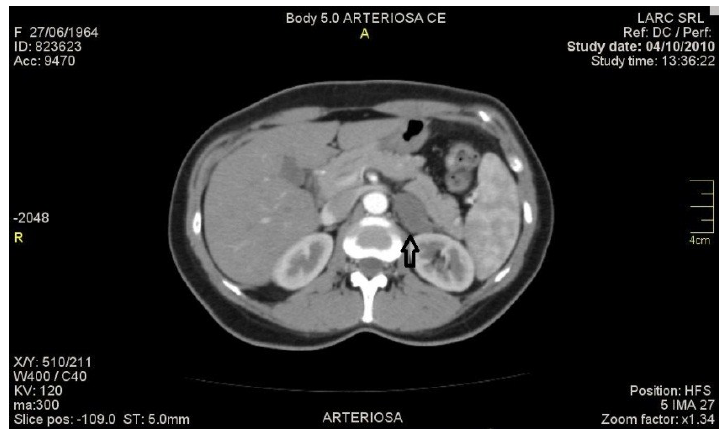
FIGURE 1. CT image: the arrow points to the left adrenal mass.